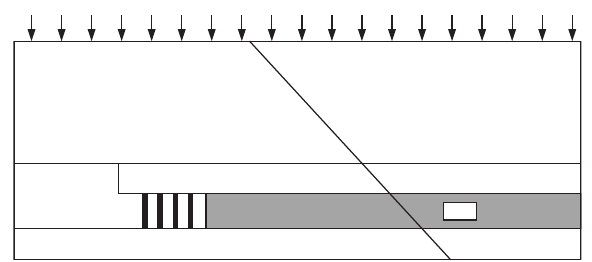
Figure 19: The numerical model of reverse direction fault (the initial